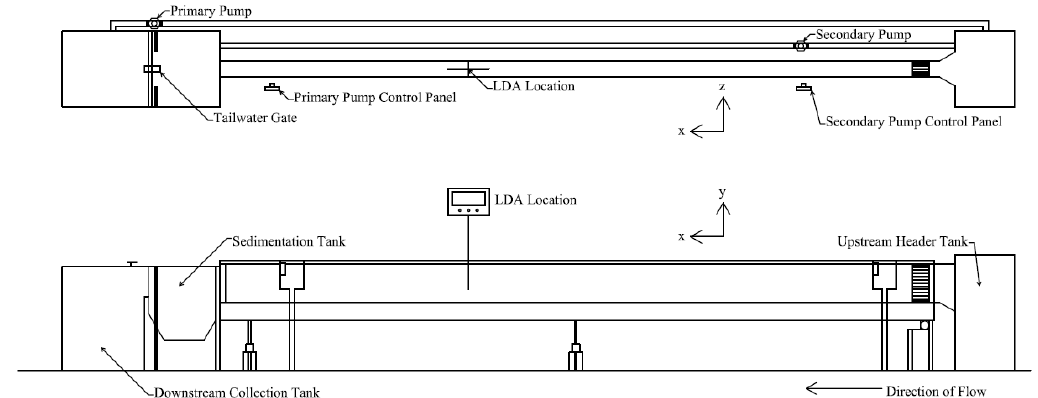
Figure 5. Rectangular inclined water tank at the Fluid Mechanics Laboratory in the University of Wollongong(UOW), Australia.